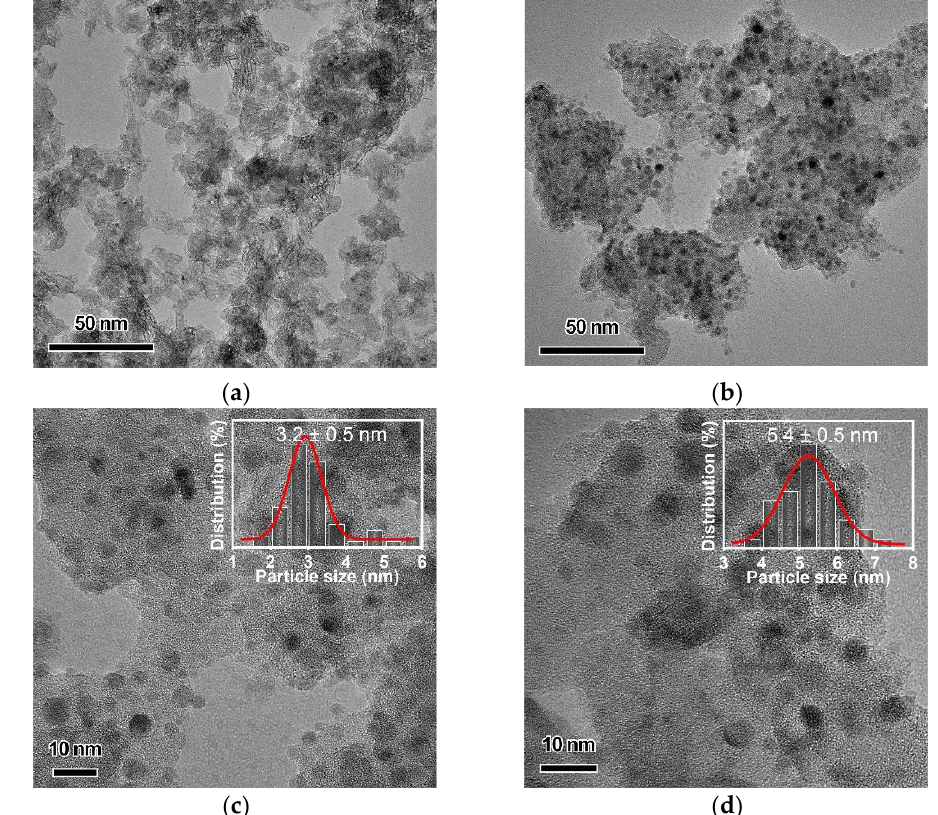
Figure 1. TEM images of ( a ) Cu/SiO 2 (AE) after calcination; ( b , c ) Cu/SiO 2 (AE) after reduction; ( d ) Cu/SiO 2 (CP) after reduction. Table 1. Physical and chemical property of Cu/SiO 2 (CP) and Cu/SiO 2 (AE) catalysts.